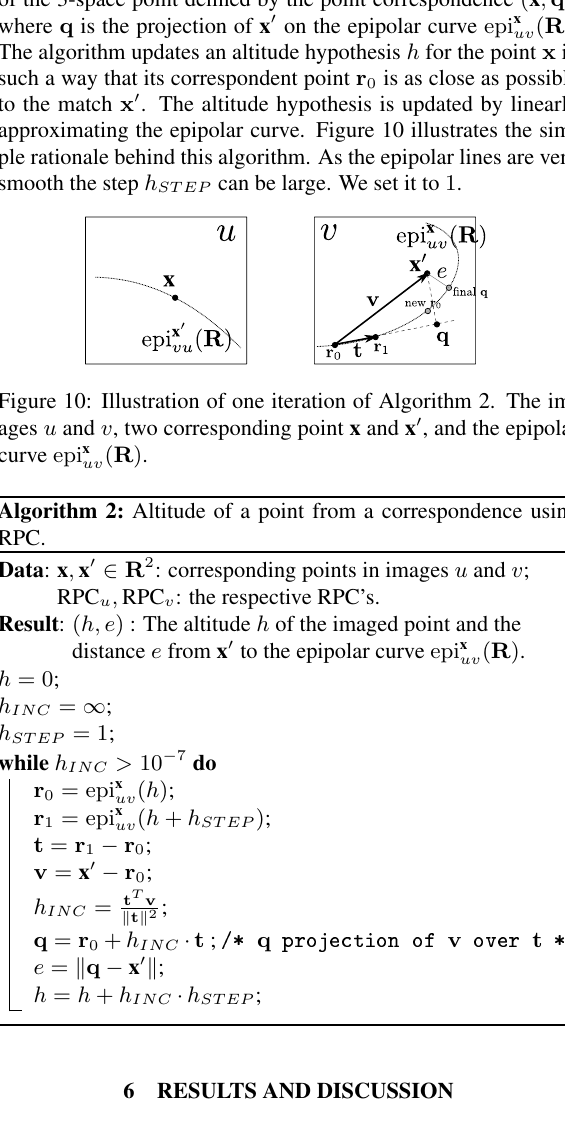
Figure 11: Dependence of the epipolar error with the tile size. A tile of size ranging from 500 × 500 to 5000 × 5000 pixels was selected in the middle of a Pléiades reference image. Virtual matches were computed using altitude ranges given by SRTM data.